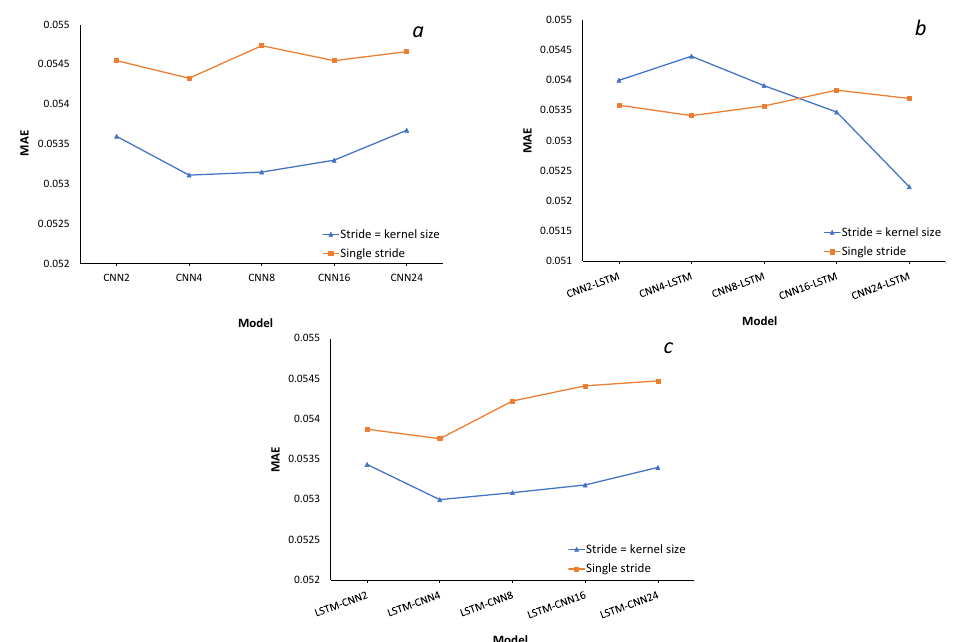
Figure 8. Mean absolute error of single and multi-stride: ( a ) CNN model, ( b ) CNN-LSTM model, and ( c ) LSTM-CNN model over different kernel